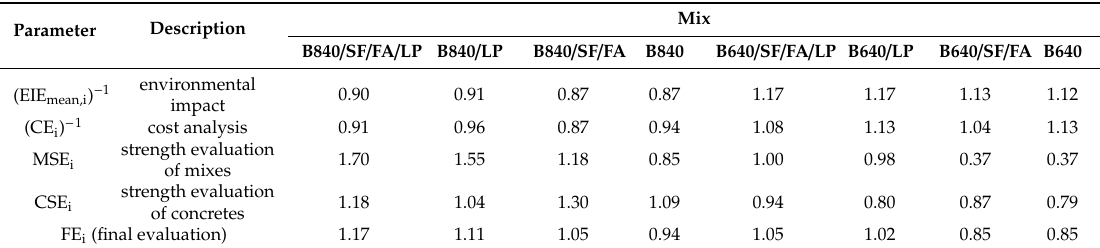
Table 11. Final evaluation of mixes potentially suitable for 3D